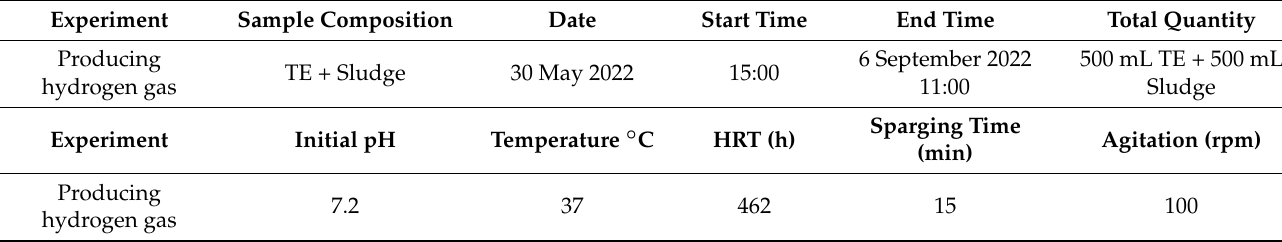
Table 3. Summary of the main parameters of the experiment.